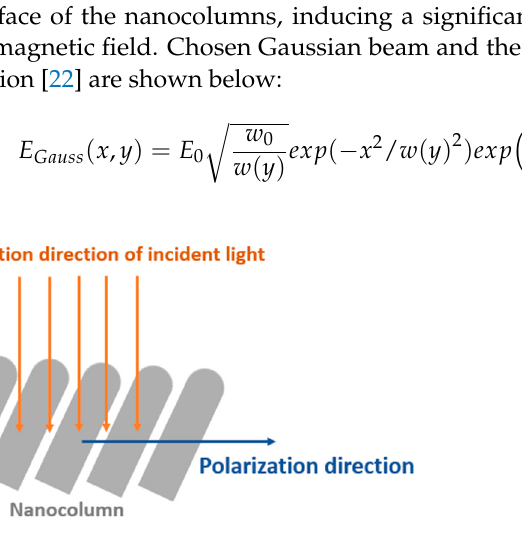
Figure 2. The diagram of nanocolumn array and incident Gaussian beam in COMSOL model.